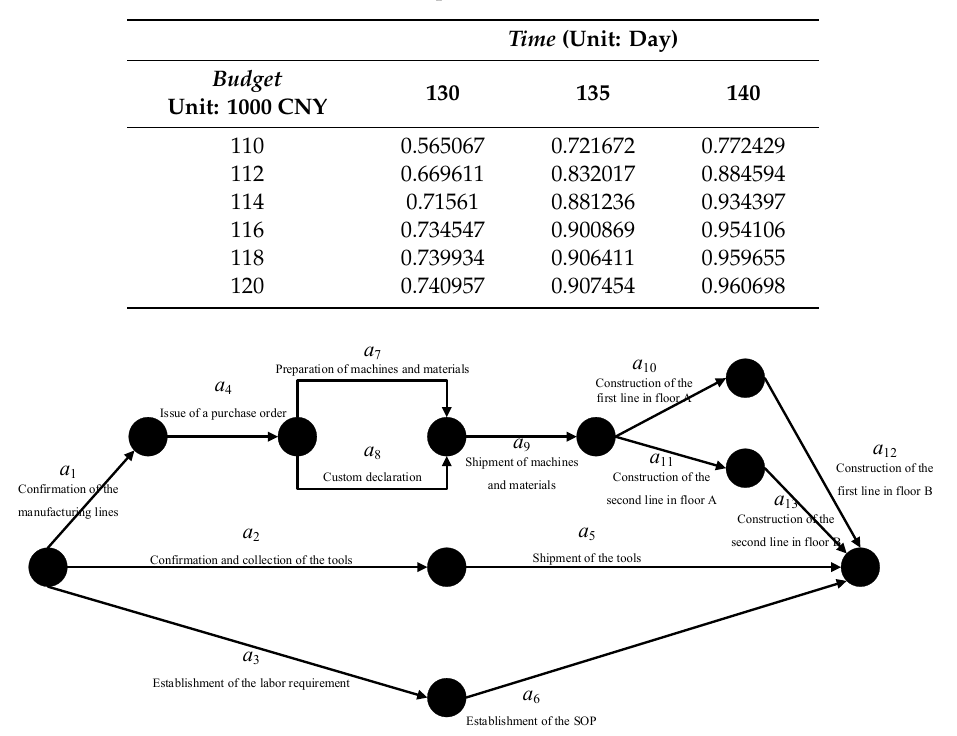
Figure 2. The project of construction of new manufacturing lines.